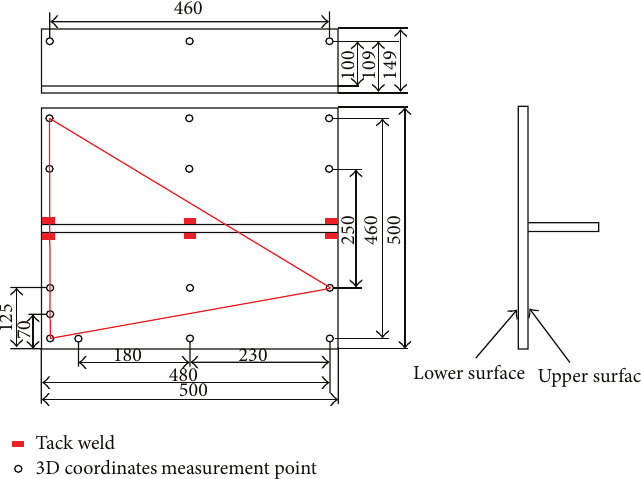
Figure 1: 3D coordinate measurement position for inverse analysis.